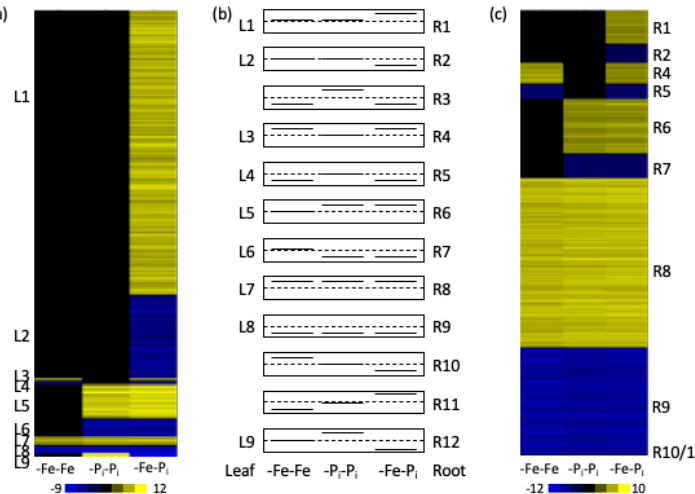
Figure 2. Distribution of statistically significant differentially expressed genes (DEGs) ( a – c ) in leaves ( a ) and roots ( c ) organized by possible expression profiles ( b ). Samples could either be downregulated (as indicated by blue in the heatmaps or by a solid line below the dashed line), not differentially expressed (black in heatmaps or solid line on the dashed line), or upregulated (yellow in heatmaps or solid line above the dashed line). Heatmaps present log2 fold changes compared to controls with minimum and maximum fold changes in each tissue provided with the expression scale. While 15 possible expression profiles were identified, only 12 profiles were identified in the data. Each cluster is assigned a unique designation. Samples from this experiment were exposed to iron deficiency followed by phosphate deficiency stress (-Fe-P i ). These expression profiles were compared to a previous study examining repeated exposure to iron deficiency stress (-Fe-Fe) and repeated exposure to phosphate deficiency stress (-P i -P i ) [34]. Table 1. Top five GO terms associated with leaf expression profiles corresponding to Figure 2.